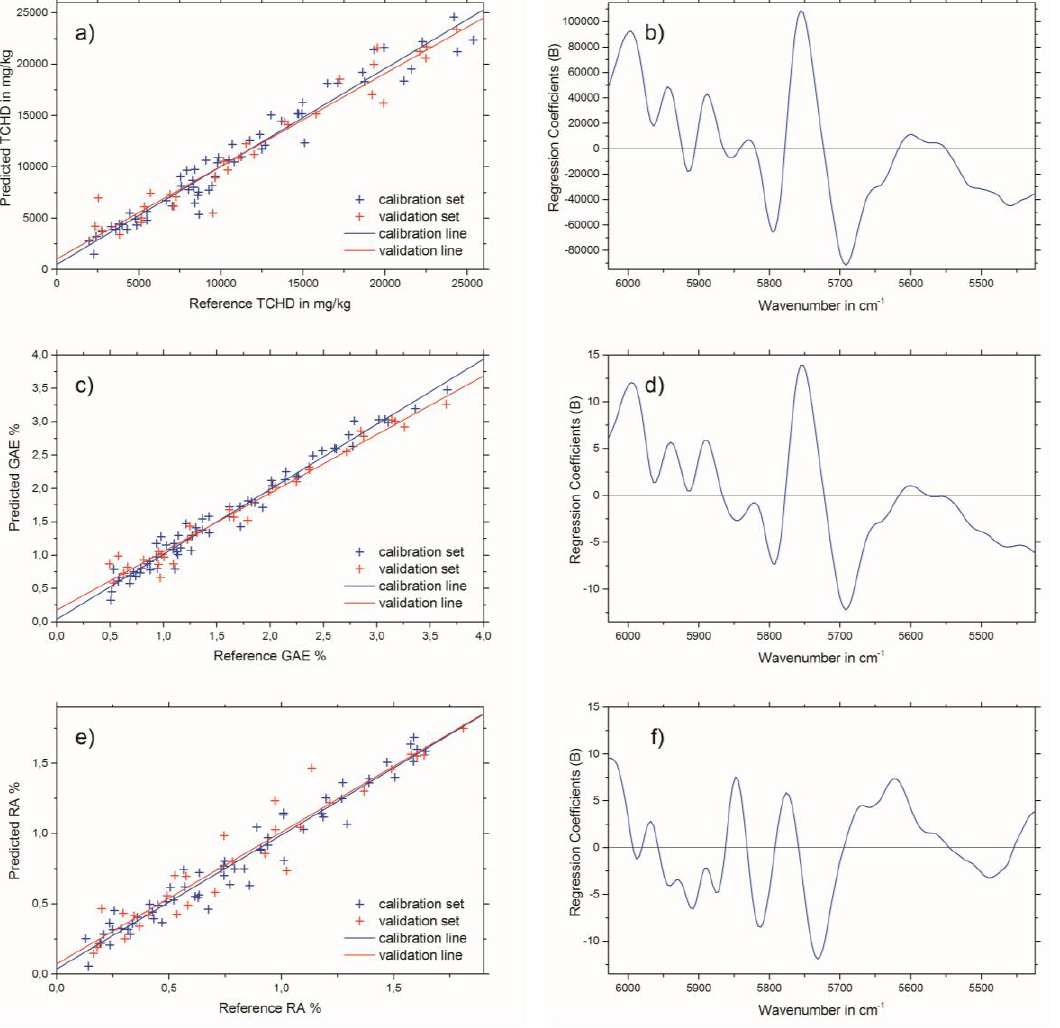
Figure 3. Predicted versus reference plots (left column) and regression coefficient plots (right column) for the best test-set validated PLSR models for: ( a ) and ( b ) THCD in mg/kg, ( c ) and ( d ) GAE%, and ( e ) and ( f ) RA%.